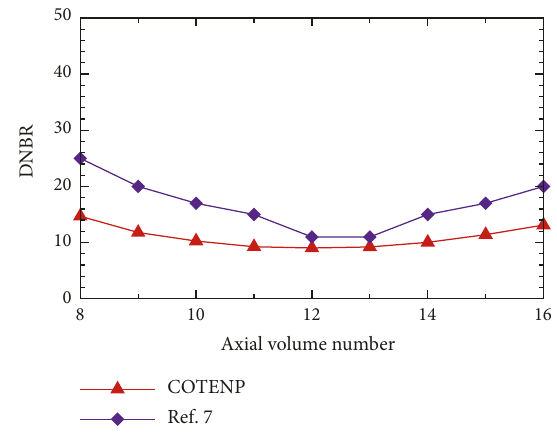
Figure 10: Comparison of DNBR results in the hottestfuel assembly for the CARR reactor between the COTENP code and reported results